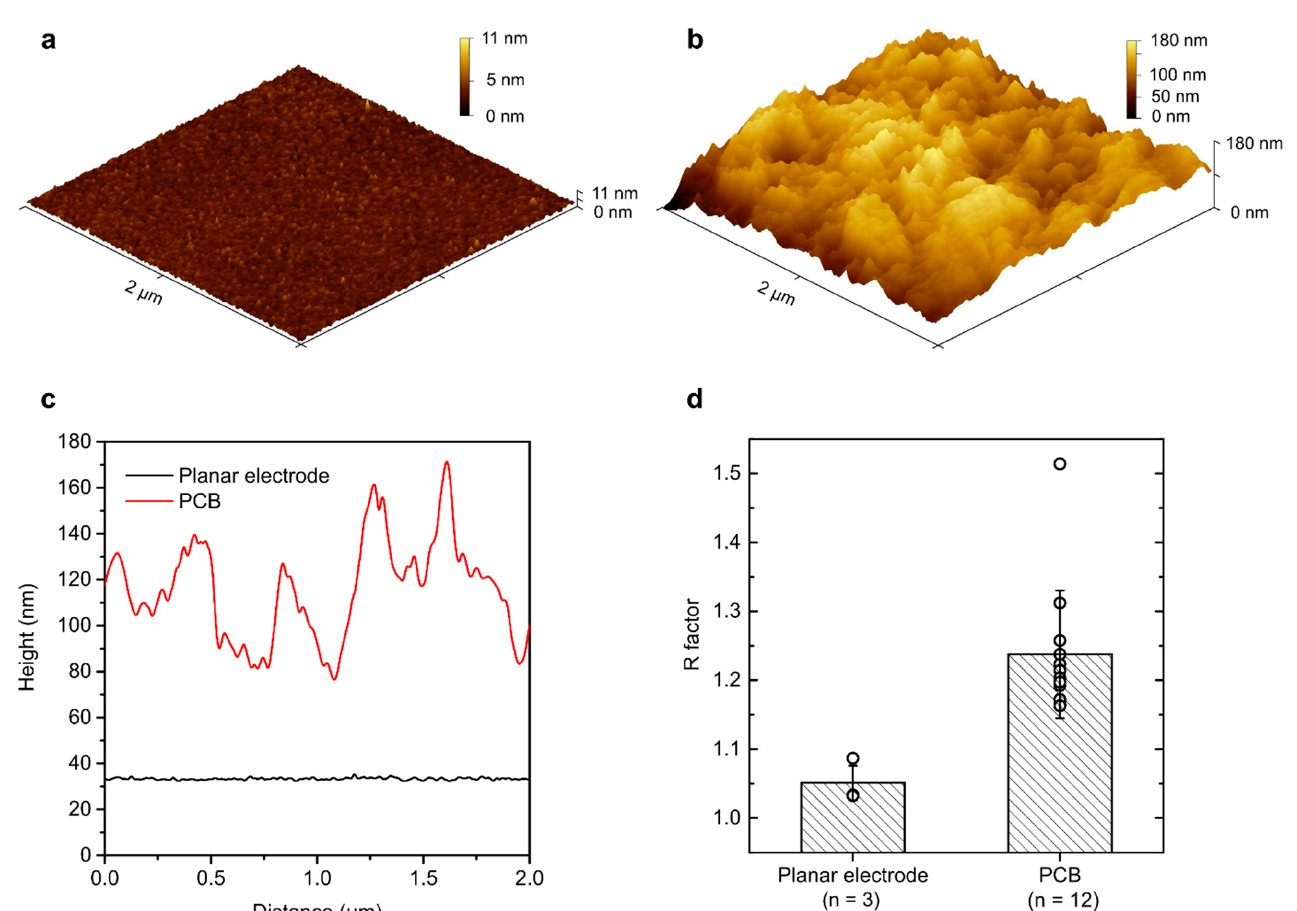
Figure 4. PCB surface roughness evaluation. ( a ) Example of the AFM profile for planar gold electrodes and ( b ) PCB electrodes. ( c ) The obtained profile from both representative samples. ( d ) Roughness factors obtained by CV scanning in H 2 SO 4 . Bars represent the mean, error bars represent the SD, and empty circles represent individual electrode datapoints.